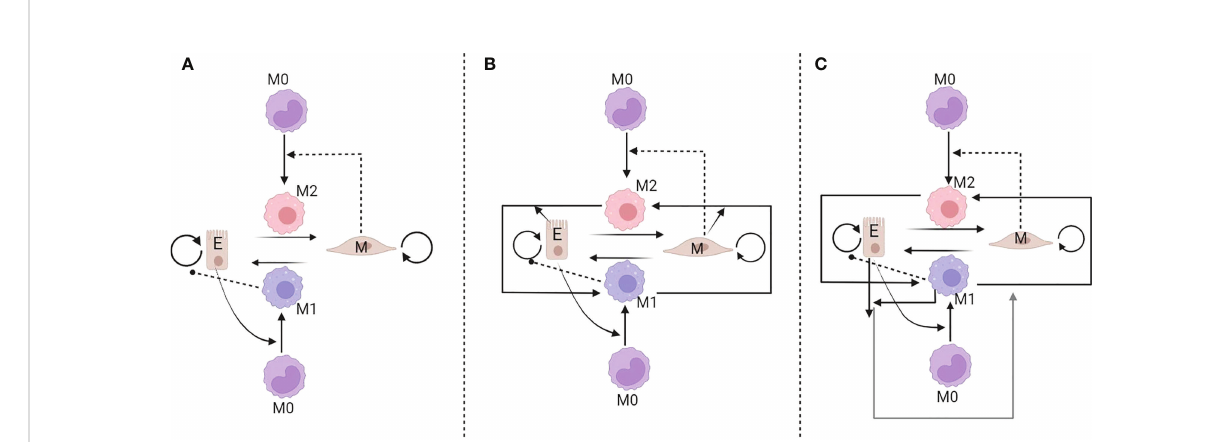
FIGURE 4 Three interaction networks developed to model the interplay between tumour and macrophages. In the model (A) epithelial cells polarize monocytes into M1-like macrophages, whereas mesenchymal cells polarize monocytes into M2-like macrophages. In models (B, C) additional feedbacks are assumed [reproduced from reference